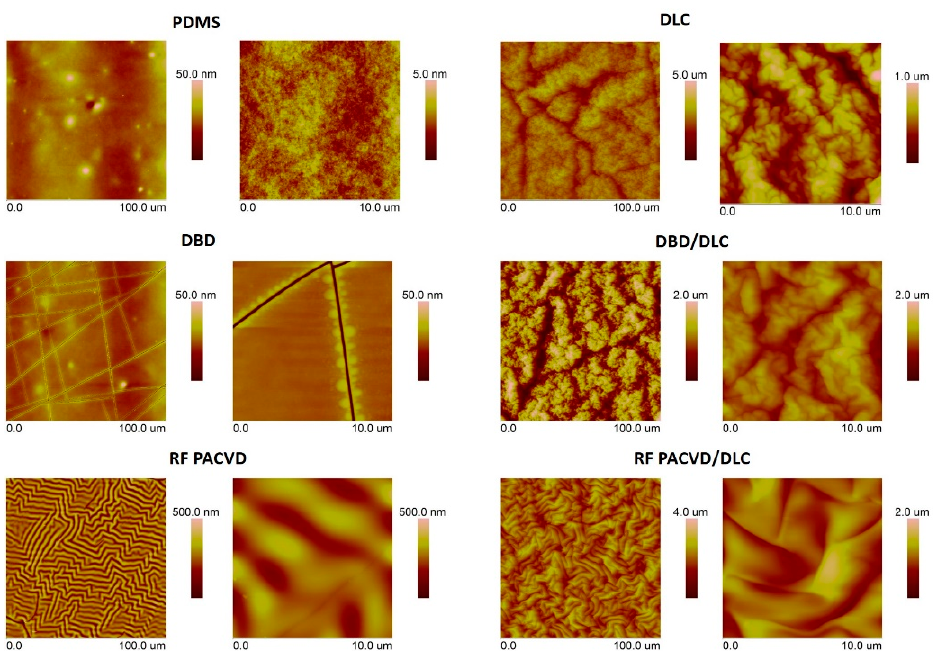
Figure 1. On the left, the AFM pictures show the surface of the polydimethylsiloxane (PDMS) substrate: unmodified, subjected to 60 s modification in DBD air plasma, and subjected to 60 s modification in low-pressure radio-frequency plasma-assisted chemical vapour deposition (RF PACVD) plasma. On the right, the pictures show the same substrates coated with a DLC layer.